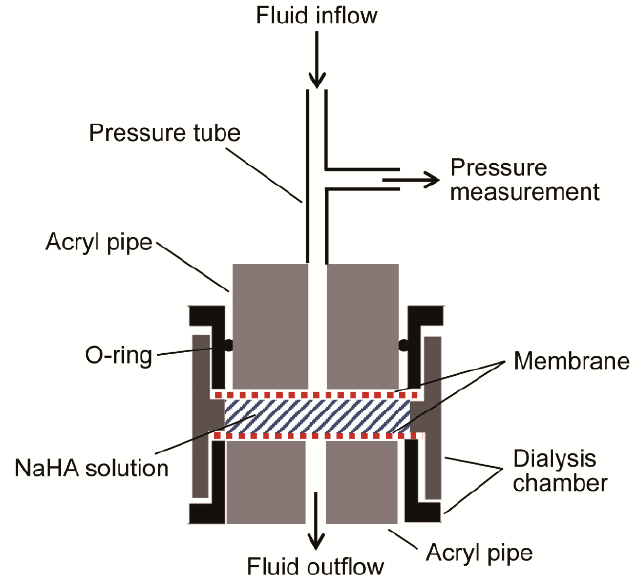
Figure 3. Experimental set-up for the measurement of Darcy’s permeability coefficient of sodium hyaluronic acid (NaHA) solution. The fluid (i.e., phosphate buffered saline or colloid solution) was infused into the dialysis chamber containing NaHA solution at a constant rate, and hydrostatic pressure in the pressure tube was continuously recorded.